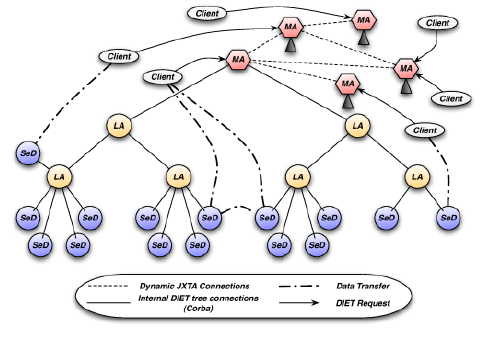
Figure 10: Architecture of DIET